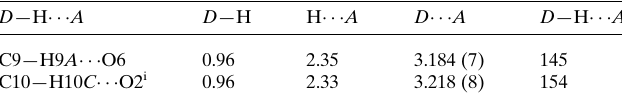
Table 1 Hydrogen-bond geometry (A˚ , (cid:5) ).